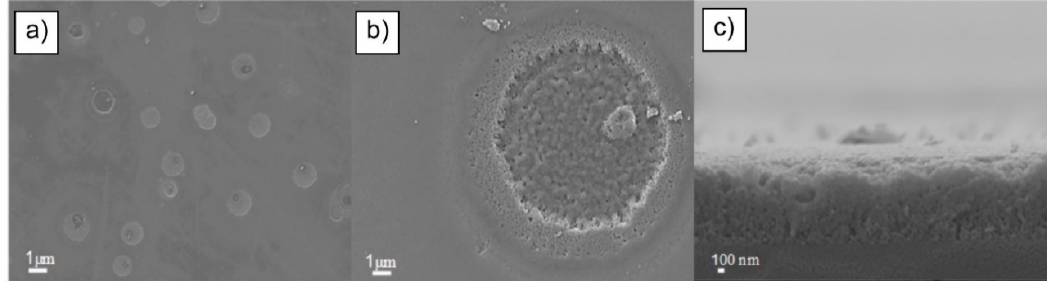
Figure 10. ( a , b ) Planar views and ( c ) cross-sectional view of a siloxane-based hydrophobic coating C (deposited by dip-coating) after 1000 h of DH exposure.